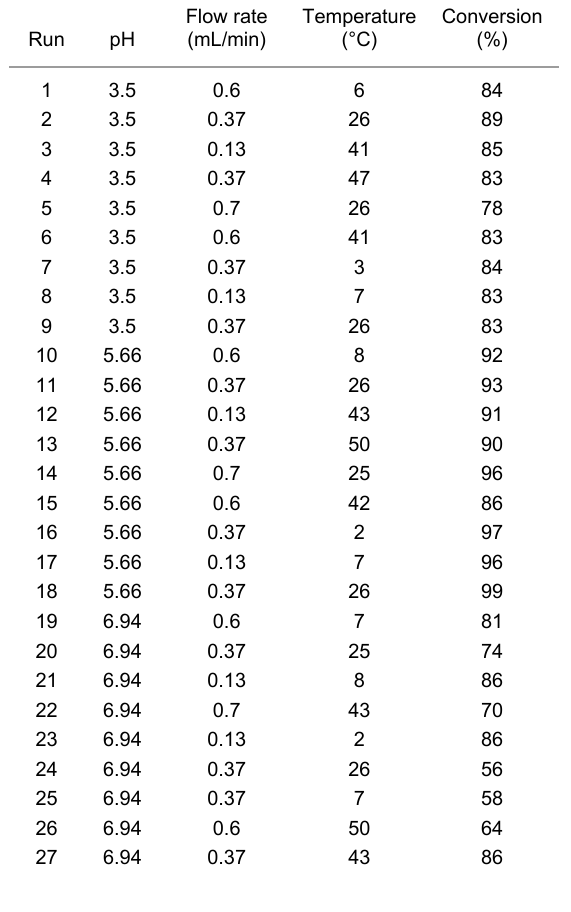
Table 3: Data showing the conversion attained at various reaction